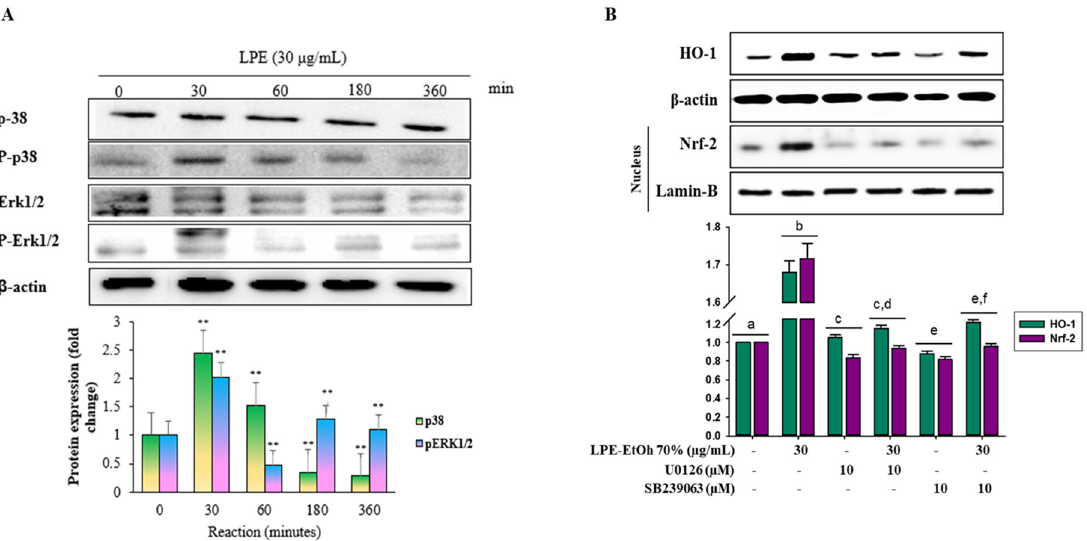
Figure 6. Effect of ethanol 70% extract Lablab purpureus L. (LPE) activates the translocation of Nrf2 by activating ERK1/2 and p38 pathways. HaCaT cells were pretreated with 2 µL of LPE 30 µg/mL for the indicated time and kinase activation was analyzed by Western blotting and band analysis was represented in adjacent figure ( A ). HaCaT cells were pretreated with LPE 30 µg/mL in the presence and absence of specific p38 and ERK inhibitors SB239063 (10 µM) and U0126 (10 µM), respectively and the protein levels of Nrf2 in nucleus fraction and HO-1 from whole-cell isolates were measured by Western blotting and band analysis was presented in adjacent figure ( B ). Statistical values are expressed as the mean ± SD ( n = 3). All the tests were performed in triplicate. Different letters stand for statistically significant each other ( p < 0.05) performed by one-way ANOVA followed by Tukey’s test.